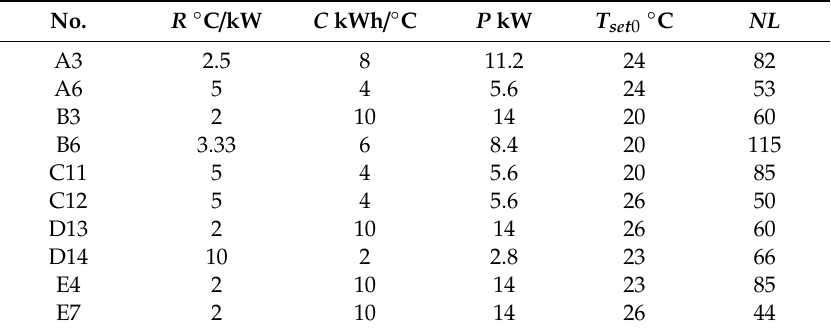
Table 2. Parameters of the selected AC groups.